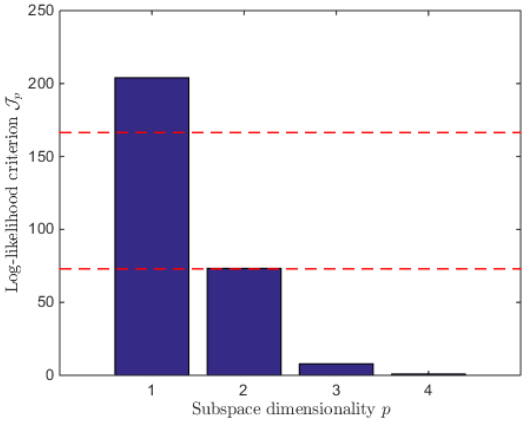
Figure 3. HB2 sequential batch culture data sets. Medium refreshment times are indicated by the arrows.